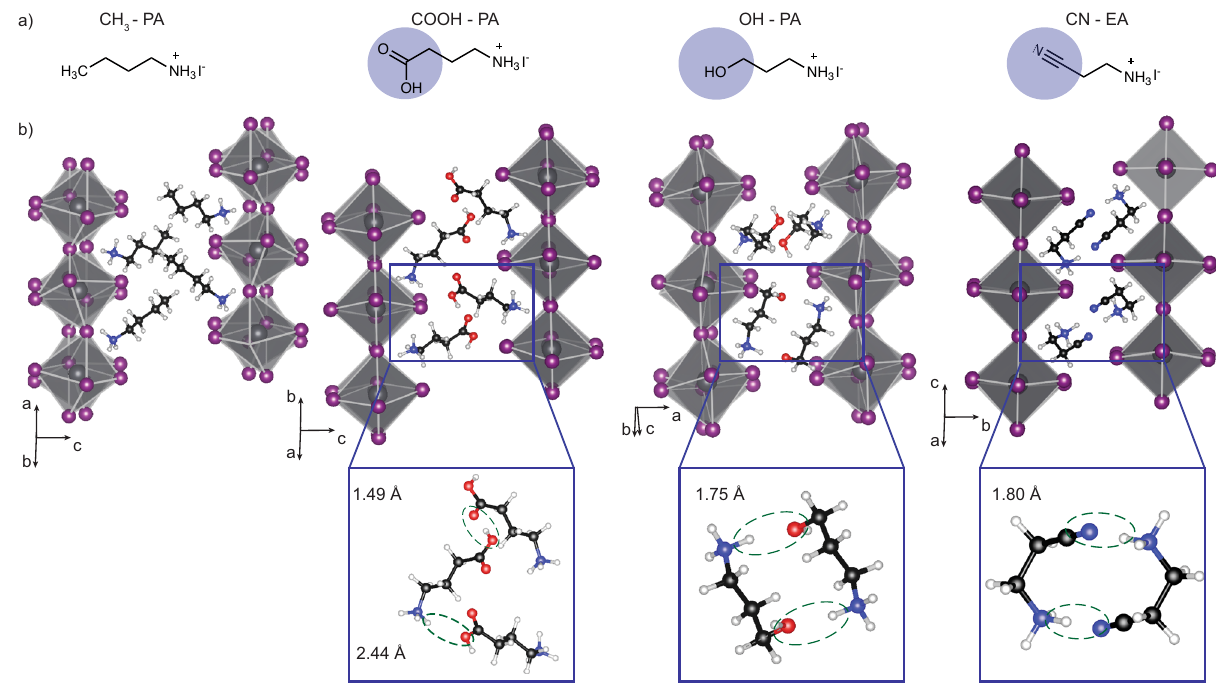
Fig. 1 Interactions between bifunctional organic ligands and inorganic octahedra. a Organic ligands used in this study. The purple circles highlight the non-ammonium terminal functional groups; b the theoretical 2D perovskite structure for (CH 3 – PA) 2 PbI 4 , (COOH – PA) 2 PbI 4 , (OH – PA) 2 PbI 4 , and (CN – EA) 2 PbI 4 . The insets show hydrogen-bonding interactions between adjacent ligands across the organic bilayer. Green dashed ovals represent close contacts between the RH 2 N + – H … R ‘ , where R ‘ = − OH in (COOH- PA) 2 PbI 4 , − OH in (OH – PA) 2 PbI 4 , and − CN for (CN – EA) 2 PbI 4